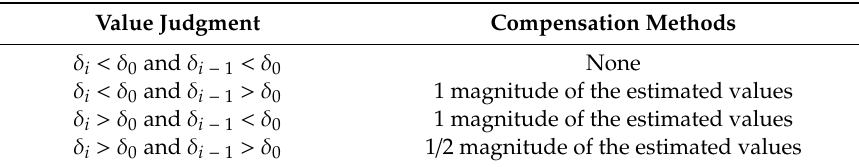
Table 2. Compensation methods of estimated